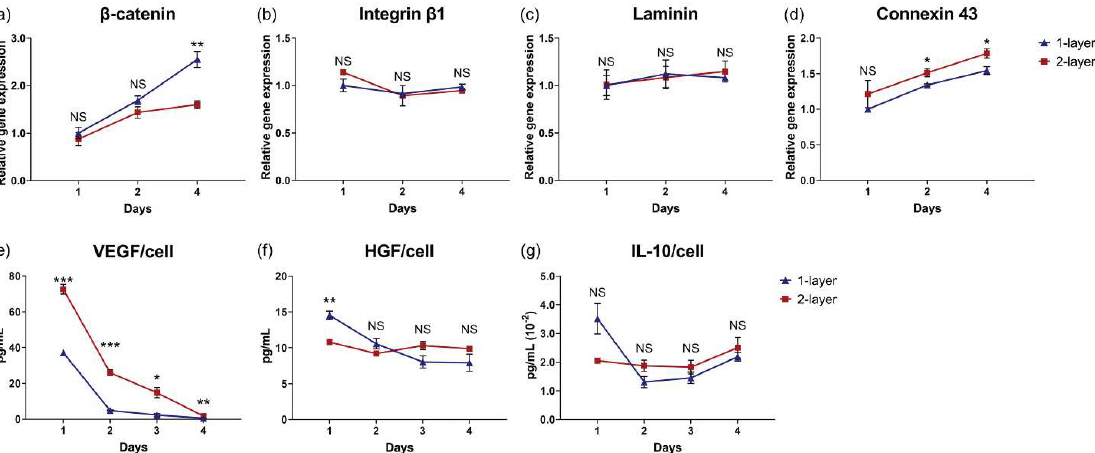
Figure 7. Cellular interactions introduced by cell sheet centrifugation layering augment MSC pro- regenerative cytokine production. Relative gene expression levels of ( a ) β-catenin, ( b ) integrin β1, ( c ) laminin α5, and ( d ) connexin 43 in 1-layer and 2-layer centrifuged cell sheets at 1, 2, and 4 days in culture. Analysis of 1-layer and 2-layer centrifuged cell sheet supernatants in static culture quantified concentrations of ( e ) VEGF, ( f ) HGF, and ( g ) IL-10 secreted per viable MSC over 4 days. Gene expression is normalized to GAPDH and compared to the 1-layer centrifuged cell sheet at 1 day. Values are means ± SE (* p < 0.05, ** p < 0.01, and *** p < 0.001). NS = not significant ( p > 0.05).